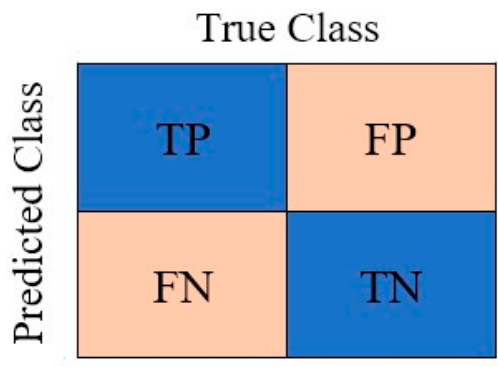
Figure 2. Binary confusion matrix.